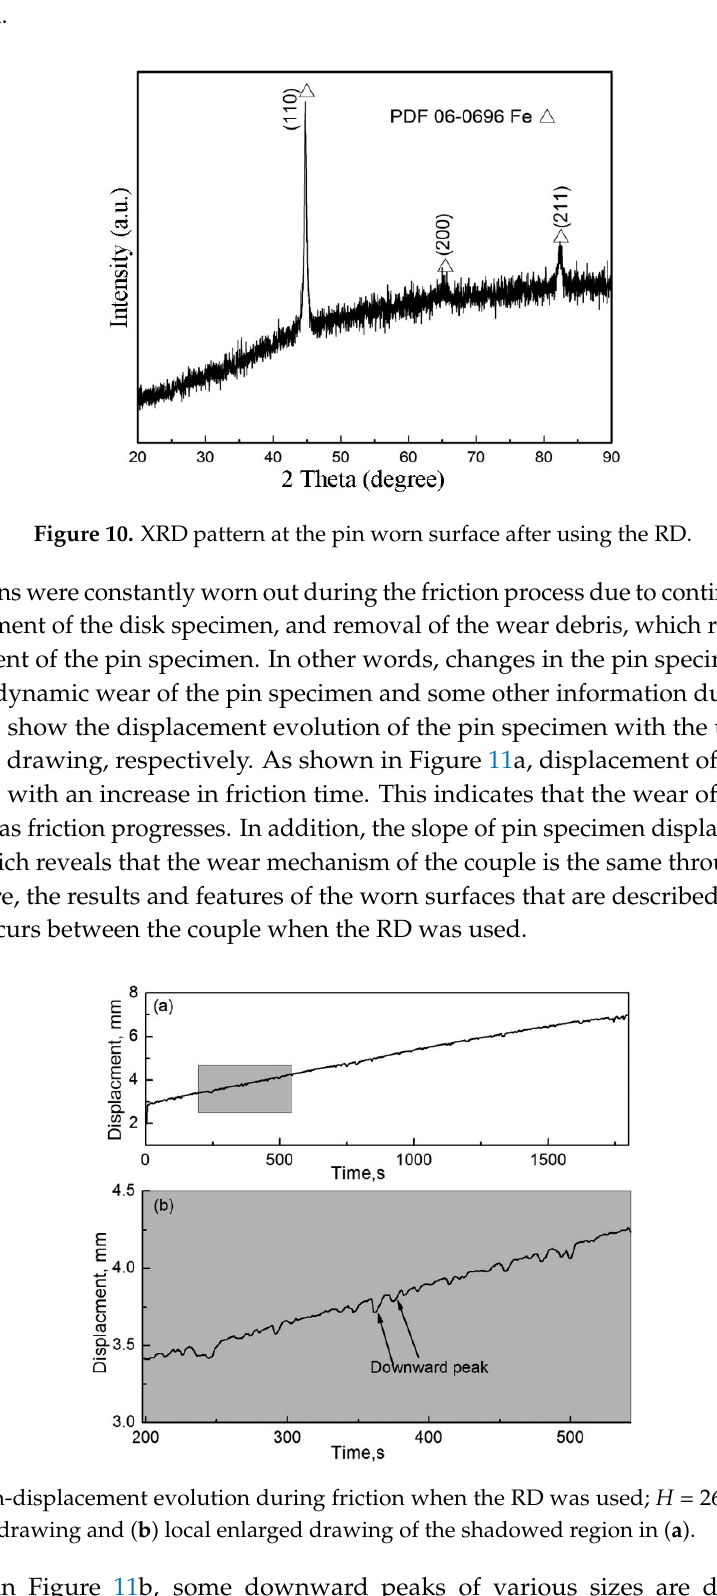
Figure 11. Pin-displacement evolution during friction when the RD was used; H = 26.1 × 10 3 A/m. ( a ) Complete drawing and ( b ) local enlarged drawing of the shadowed region in (a).